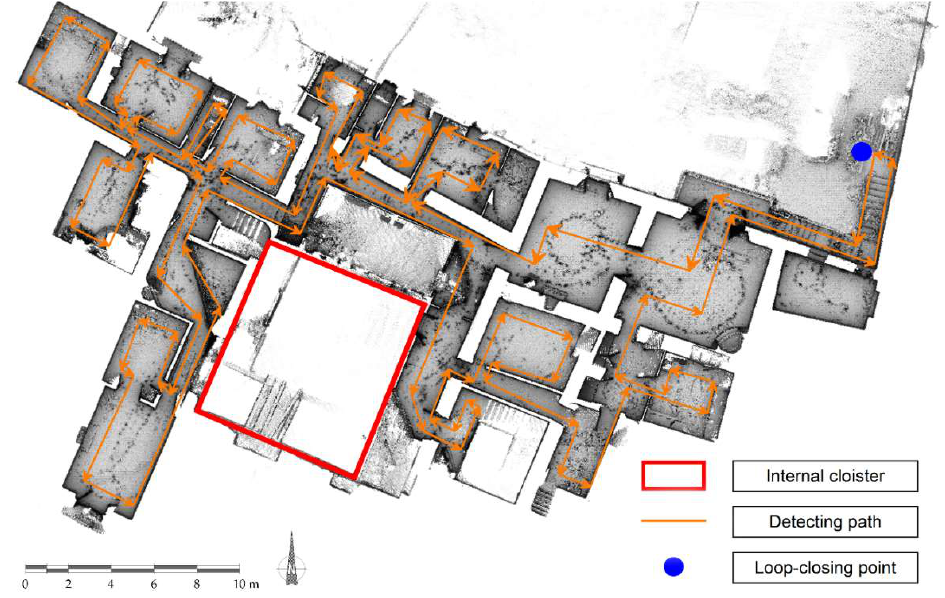
Figure 3. Example of a survey design with the WMLS. The compensation of the accumulated error is possible thanks to the closure of the path following different track and acquiring the internal cloister area from different points of the route.